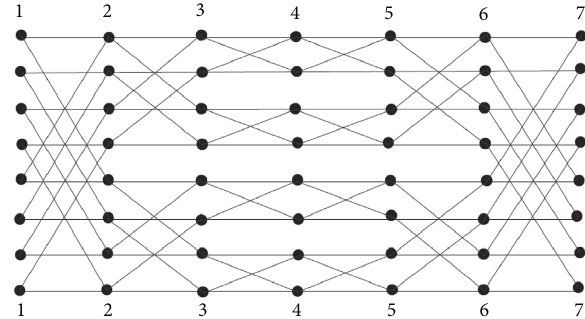
Figure 2: 3D horizontal cylinderical Benes network.